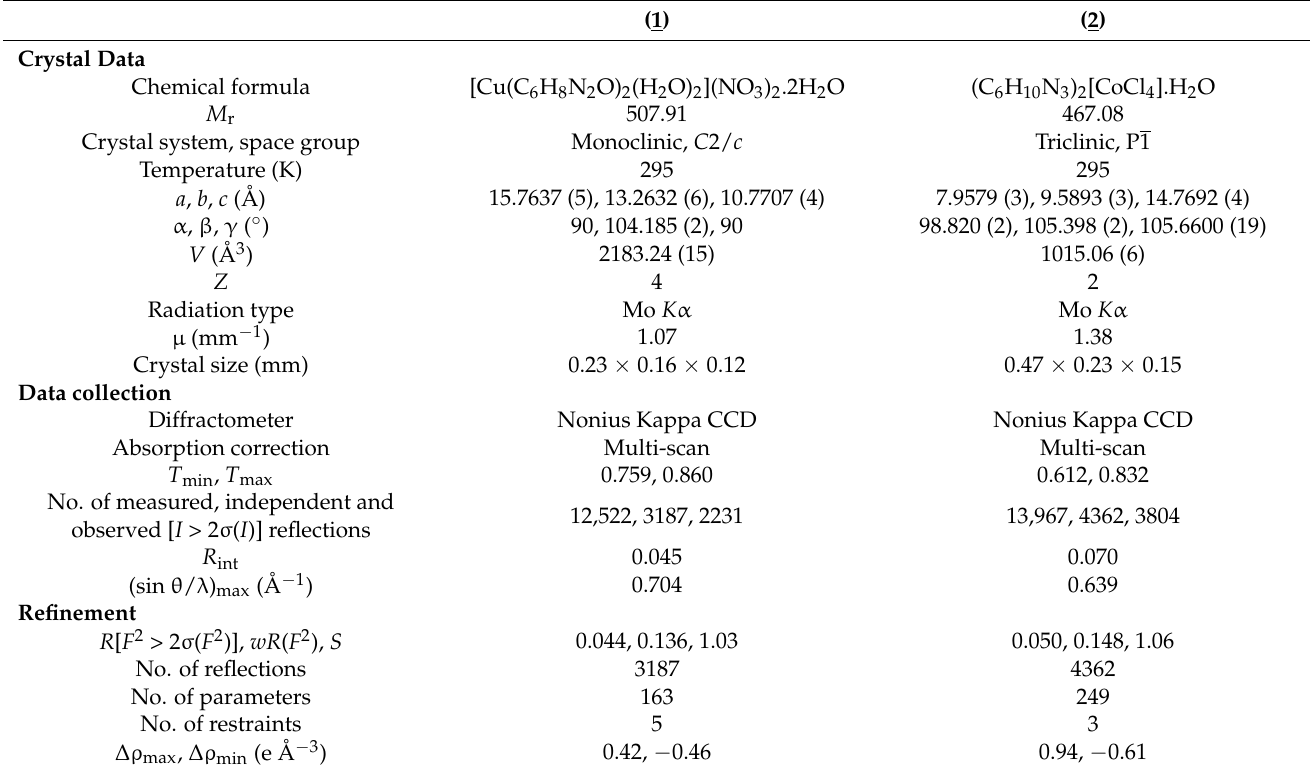
Table 1. Experimental details of compounds ( 1 ) and ( 2 ).